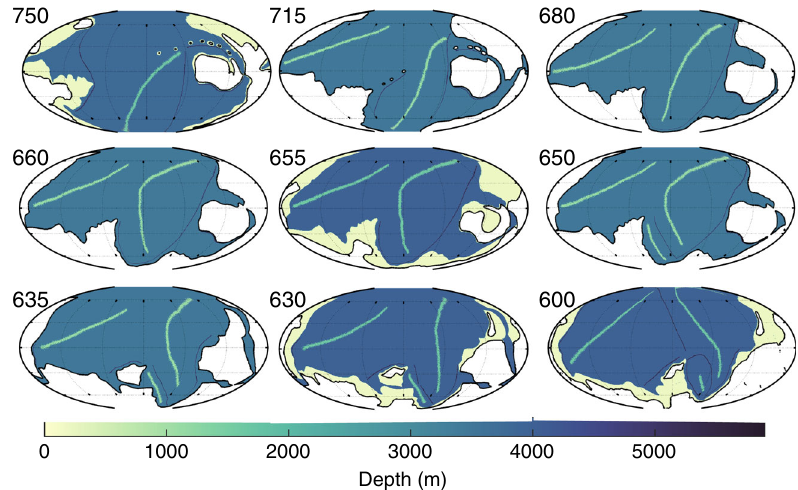
Fig. 3 The ocean bathymetry for nine key time slices. Shown is the ocean bathymetry, with depths in colour land white. Note the age for each time slice marked by the label at top left corner, and the black contour marking the coastline and the lack of shelf seas during the glaciations (715 – 660 Ma and 650 – 635 Ma). The green lines in the deep ocean mark the peaks of the oceanic ridges and the dark grey lines show trenches.